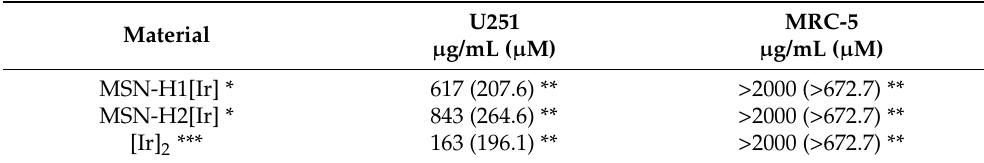
Table 3. MC 50 (IC 50 ) values of the U251 and MRC-5 cells treated for 48 h after dispersing/dissolving materials in DMSO.